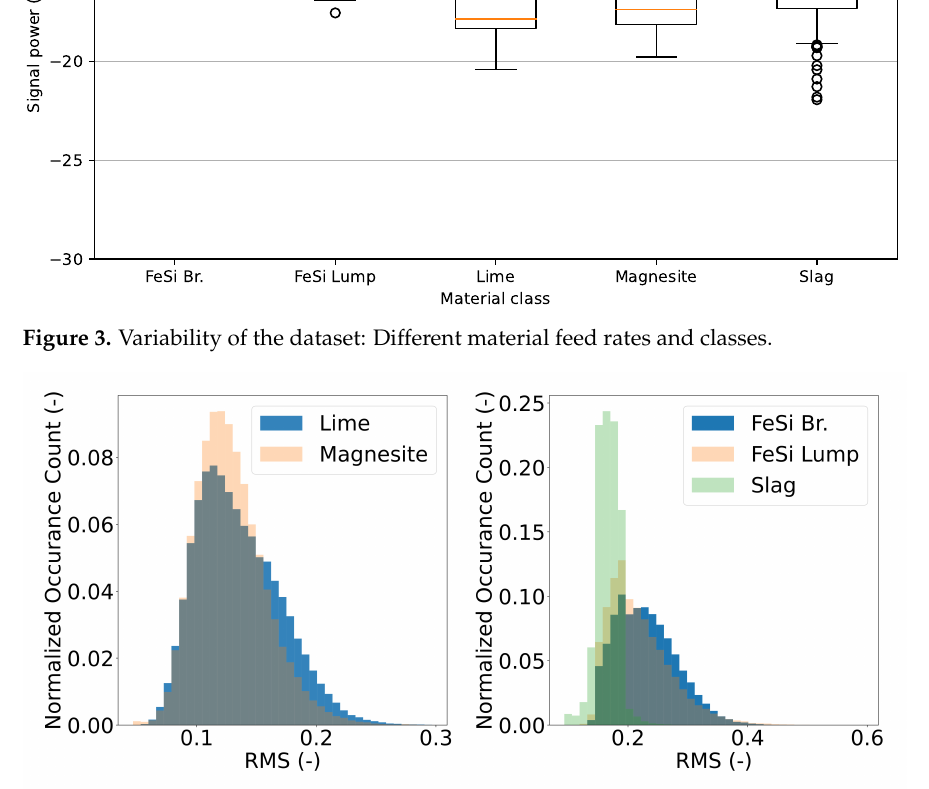
Figure 4. RMS of the dataset computed on frames of 25 ms width: ( left ) softer materials and ( right ) harder